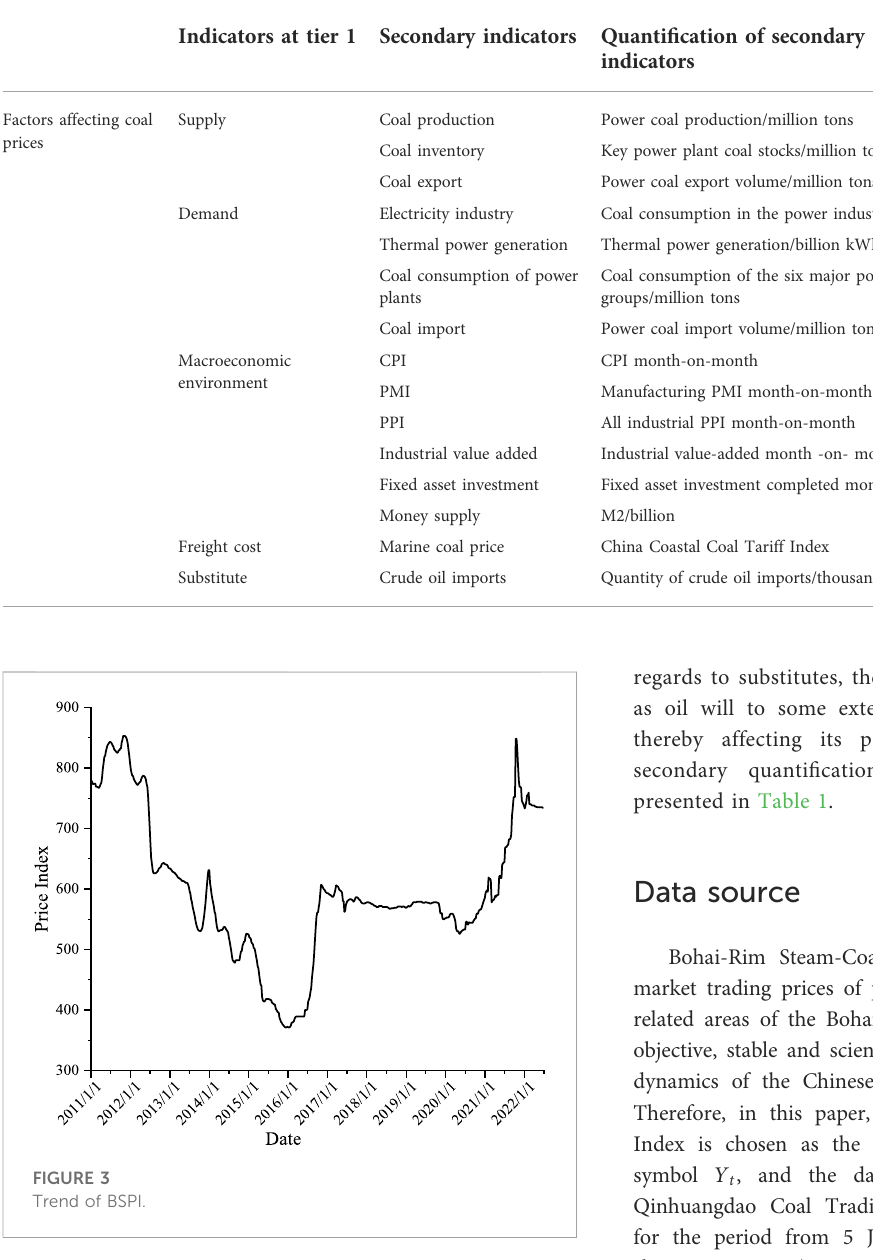
TABLE 1 Coal prices comprehensive impact factors indicators table.